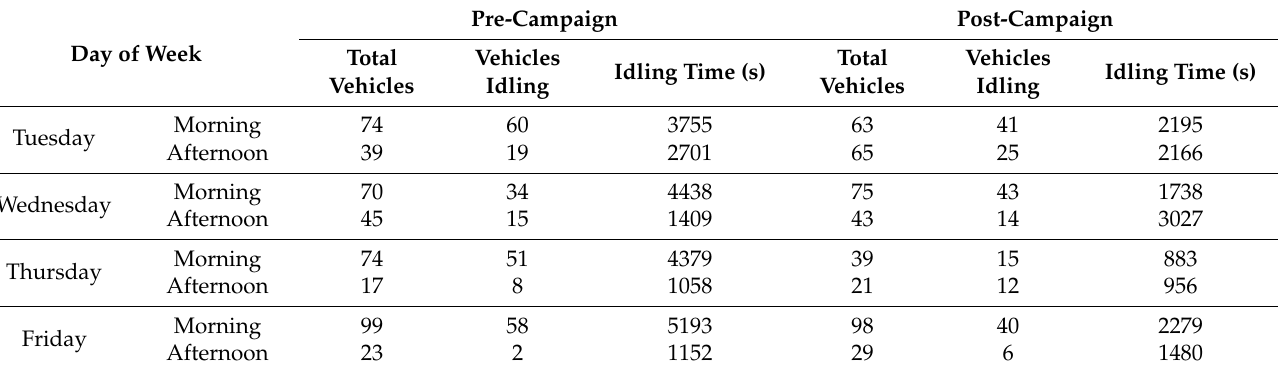
Table 10. Bonneville Elementary Idle-Free Campaign aggregated and average values.